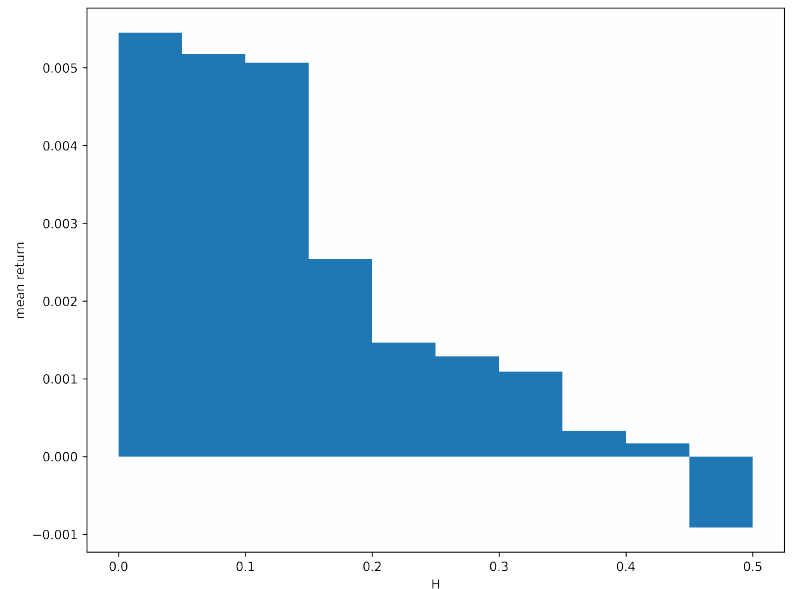
Figure 3. Comparison between the value of H and the mean return of the portfolios for the pe-